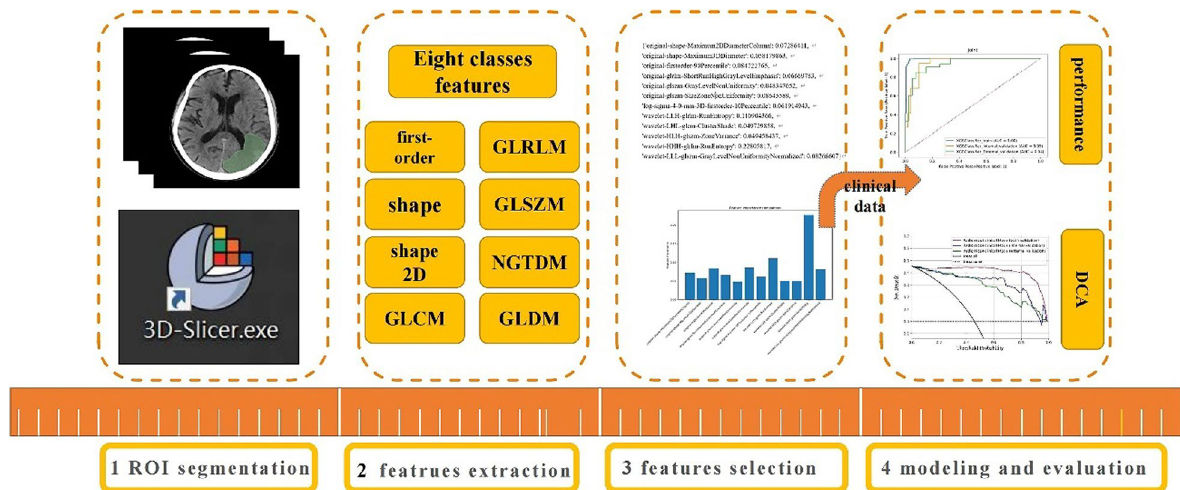
Fig. 3 Workflow of the clinical–radiomics model of predicting HT after IVT (IVT, intravenous thrombolysis; HT, hemorrhagic transformation; DCA, decision curve